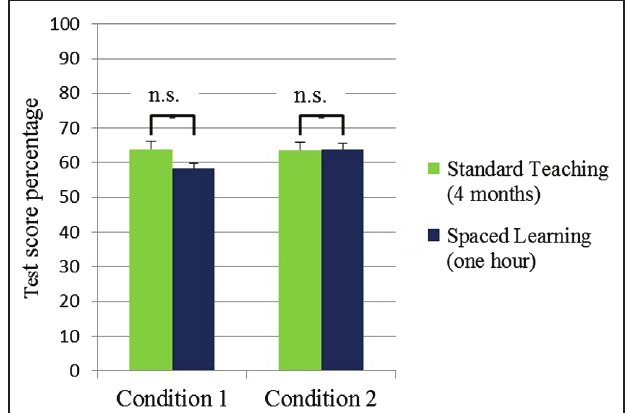
FIGURE 1 | High-stakes test scores for teaching (four months) and spaced learning (one hour). There was no significant difference between the test scores for teaching ( N = 127) and spaced learning ( N = 46) groups in Condition 1. In Condition 2 there was also no significant difference between teaching test scores ( N = 131) and spaced learning test scores ( N = 21). All data are means ± SEM.